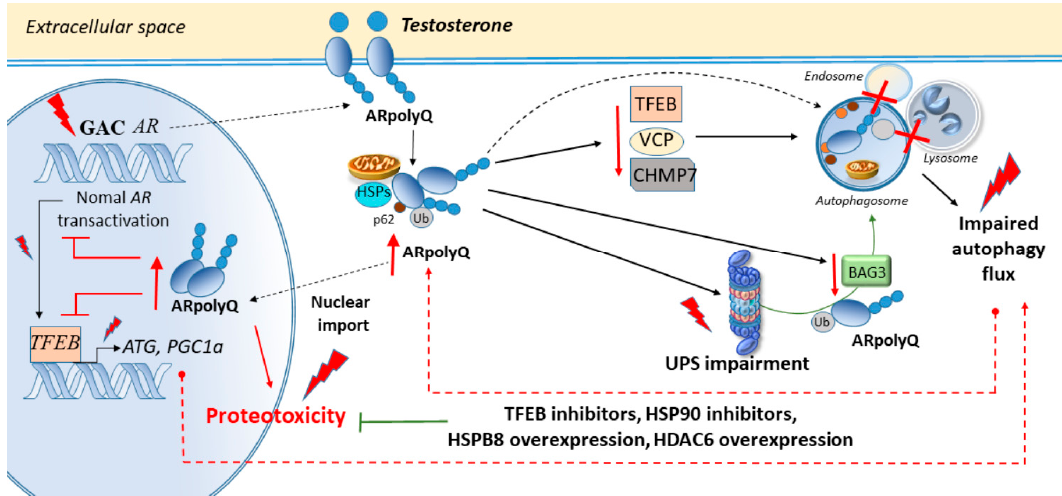
Figure 3. Androgen receptor ( AR ) repeat expansions produce proteotoxicity through autophagy and UPS impairment. A CAG expansion in the AR produces a long polyglutamine tract (polyQ) in the AR protein. The mutant AR (ARpolyQ) misfolds, and upon activation by the AR ligand testosterone, it forms cytoplasmic and toxic nuclear aggregates through a gain-of function mechanism. ARpolyQ occludes autophagy by decreasing transcription factor EB (TFEB), VCP, charged multivesicular body protein 7 (CHMP7), and also BAG3, which is activated as a compensatory response following UPS impairment by ARpolyQ. ARpolyQ nuclear accumulation may also lead to a loss of normal AR transactivation while further impairing autophagy. In fact, while normal AR promotes the activation of the autophagy inducer TFEB, ARpolyQ impairs both normal AR transactivation and TFEB-dependent autophagy, eventually promoting the accumulation of cytoplasmic ARpolyQ species which are imported in the nucleus to produce toxicity. Boosting ARpolyQ cytoplasmic clearance through autophagy and UPS inducers contributes to decreasing ARpolyQ nuclear accumulation and toxicity.